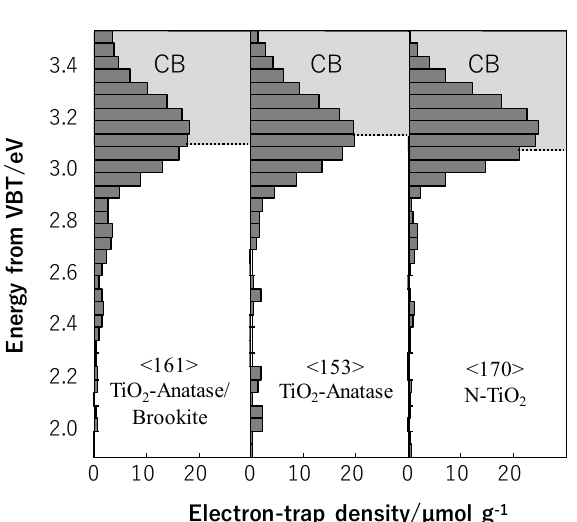
Figure 7. Electron trap densities of TiO 2 samples prepared by the sol-gel method and calcinated at 400 °C [35].